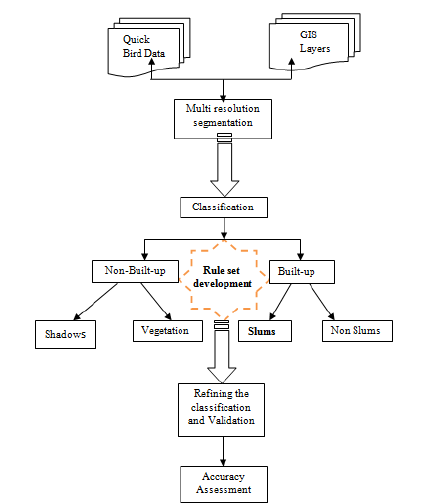
Figure 2 Flow Chart showing the methodology